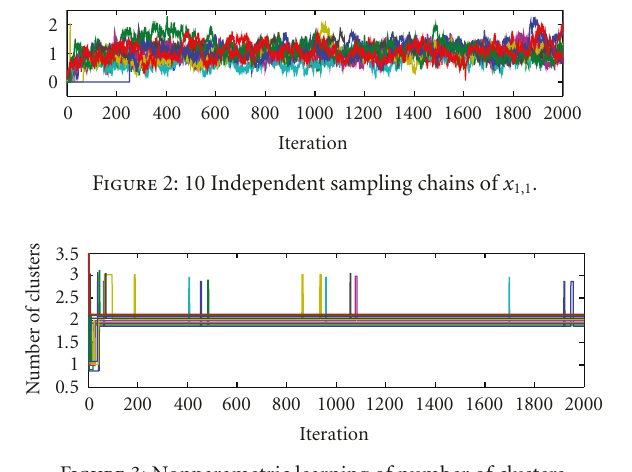
Figure 3: Nonparametric learning of number of clusters. Table 1: Estimation of parameters x 1,1 and a 1,1